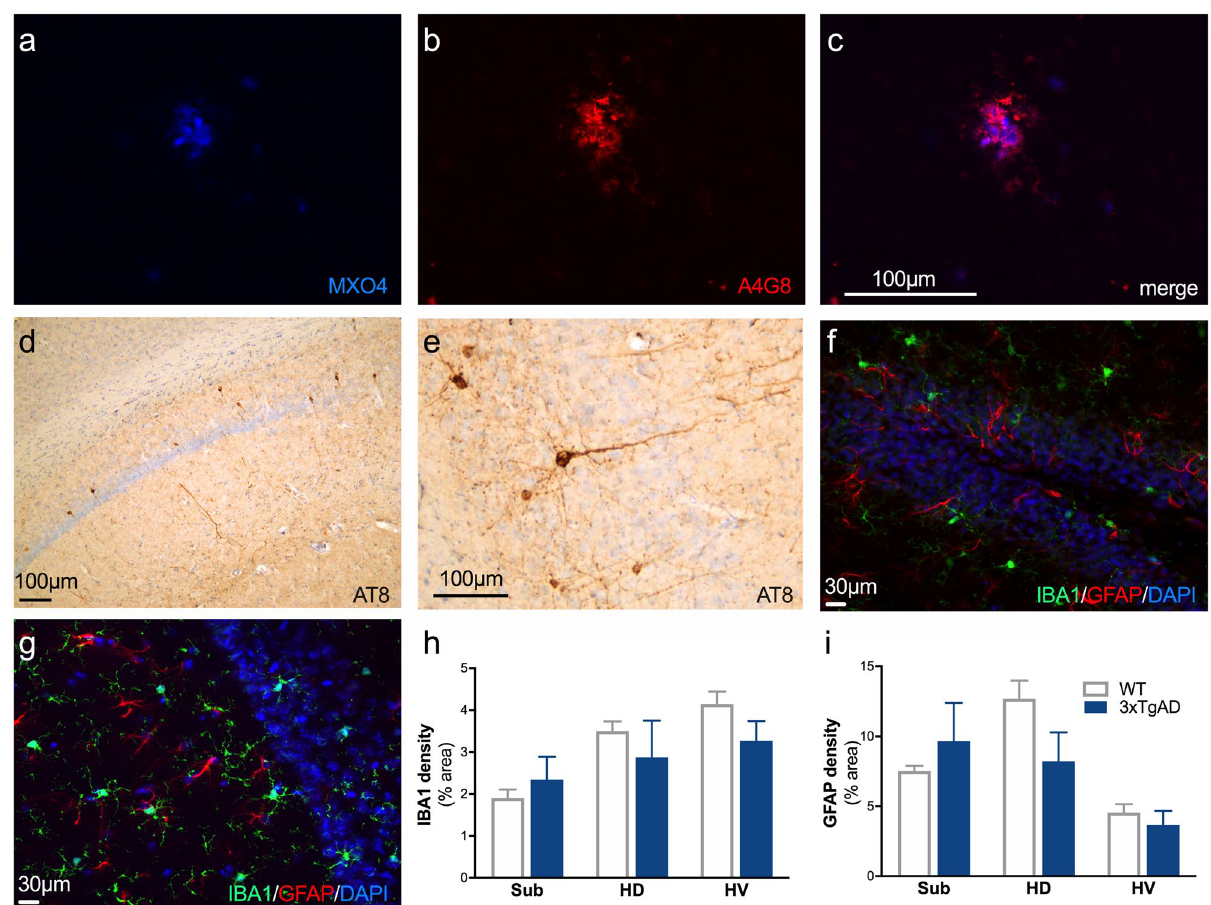
Figure 4. Sparse Aβ deposits restricted to the subiculum and low Tau levels in the hippocampus of 3xTg-AD mice. (a–c) A weak positive labeling of amyloid plaques with MXO 4 (blue, a ) and A4G8 (red, b ) is observed and restricted to the subiculum. (c) Merge image of A and B. (d) A weak positive labeling for AT8 is observed only at the level of the hippocampus. (e) Example of positive AT8 cells showing positive cell bodies and neurites. (f,g) Example of immunofluorescence for DAPI (blue), IBA1 (green) and GFAP (red) in dentate gyrus (f) and dorsal hippocampus (g) . (h,i) Quantification of the area occupied by IBA1 (h) and GFAP (i) staining in hippocampal